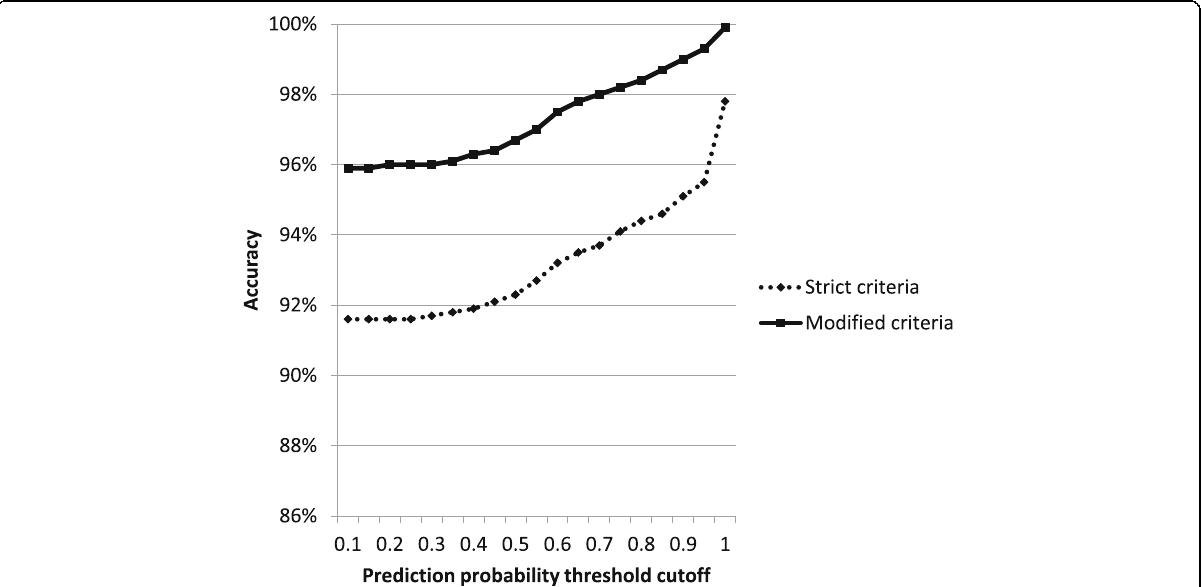
Fig. 4 Accuracy of the algorithm in correctly labeling statements by strict and modified criteria at various prediction probability